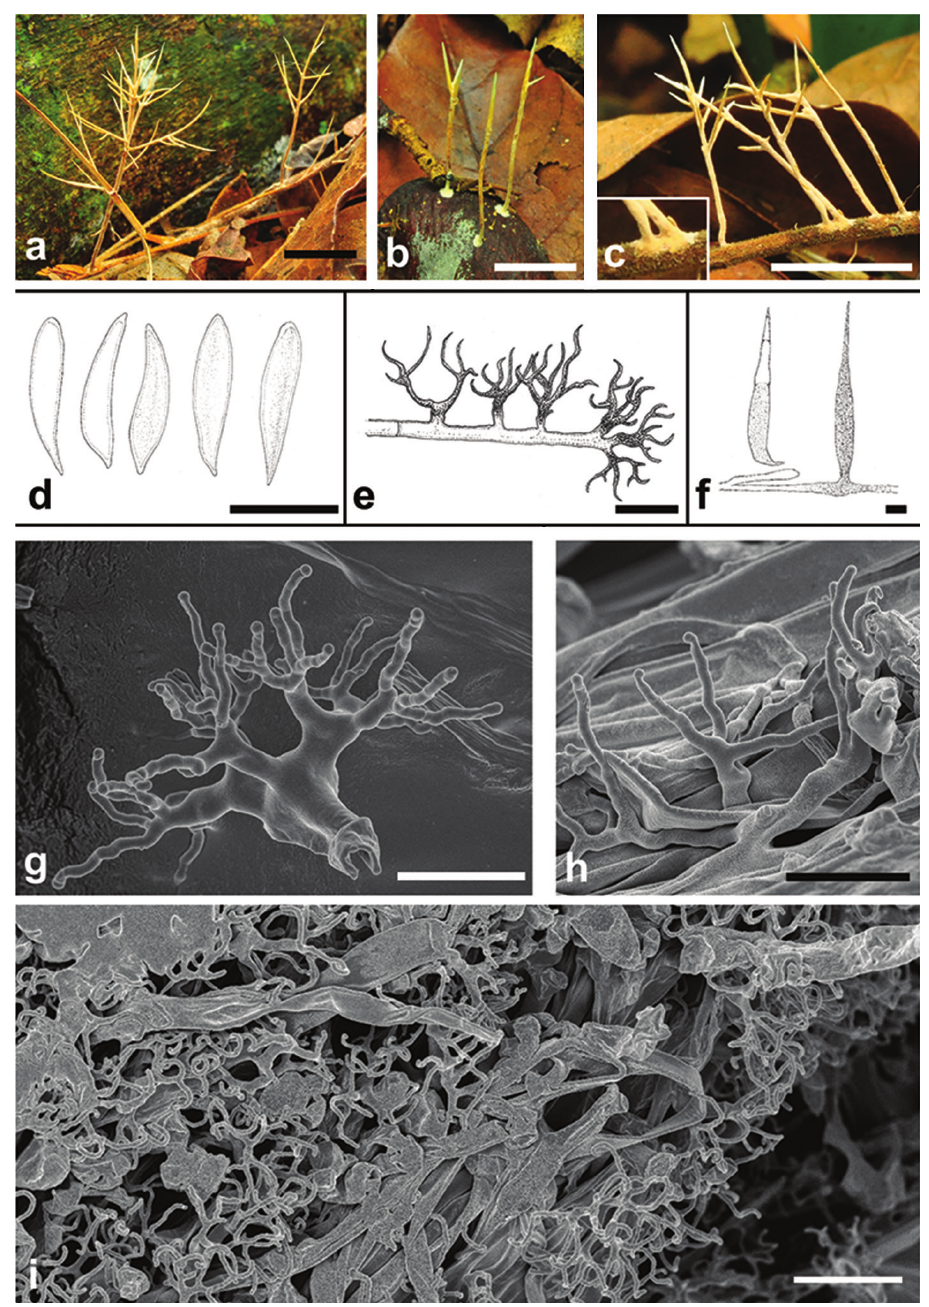
Figure 2. Parapterulicium subarbusculum : a–c basidiomes in the field. The detail in c shows the developing corticioid patch d basidiospores e dichophyses f gloeocystidia g, h SEM images of dichophyses; i. SEM im- ages of basidiome surface with abundant dichophyses. Scale bars: a–c = 1 cm; d–f, i = 10 µm; g, h = 5